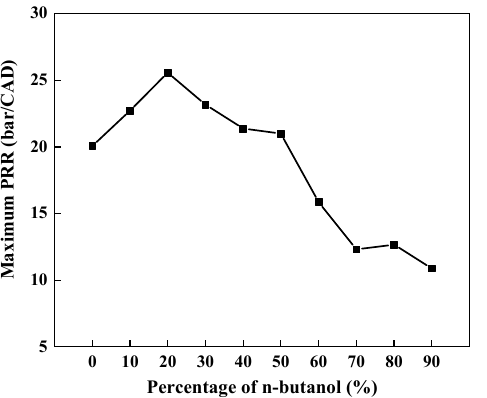
Figure 10. Comparison of maximum pressure rise rate under different n-butanol percentages.